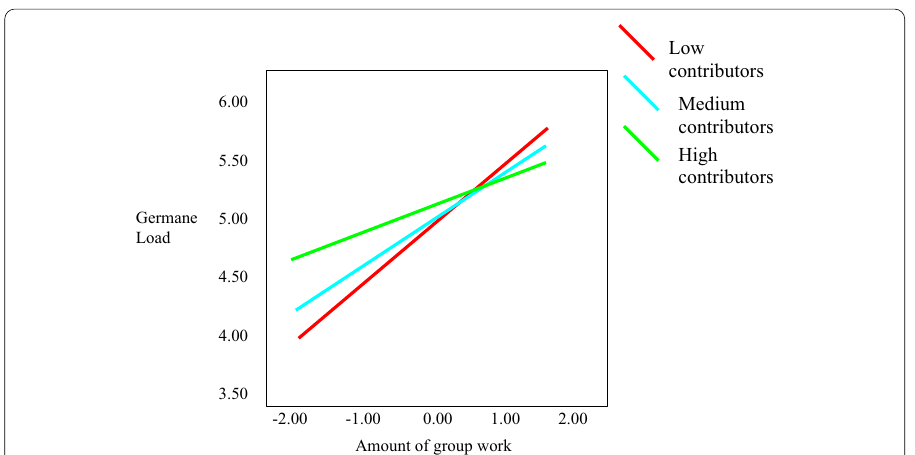
Fig. 2 The moderating effect of group contribution on the relationship between amount of group work and germane